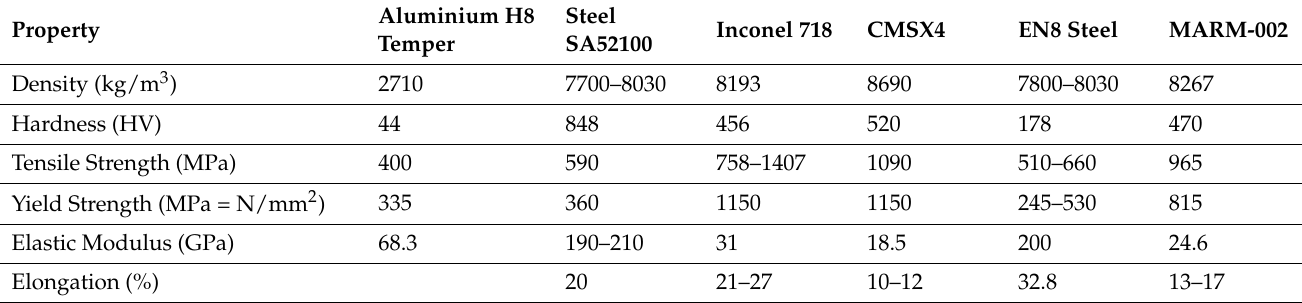
Table 3. Properties of materials used in this